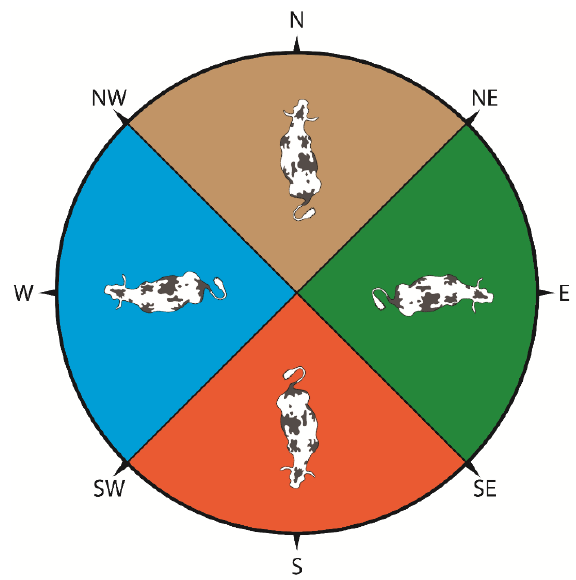
Figure 2. Orientation of cows on pasture in Uruguay. Cows in the northern quarter (beige) with their shoulders between northwest and northeast were scored as “north”; the same principle was used for cows in the eastern quarter (green), scored “east”; in the southern quarter (orange), scored “south”; and in the western quarter (blue), scored “west”. Illustration by van Erp, M.J., 2018 [9].